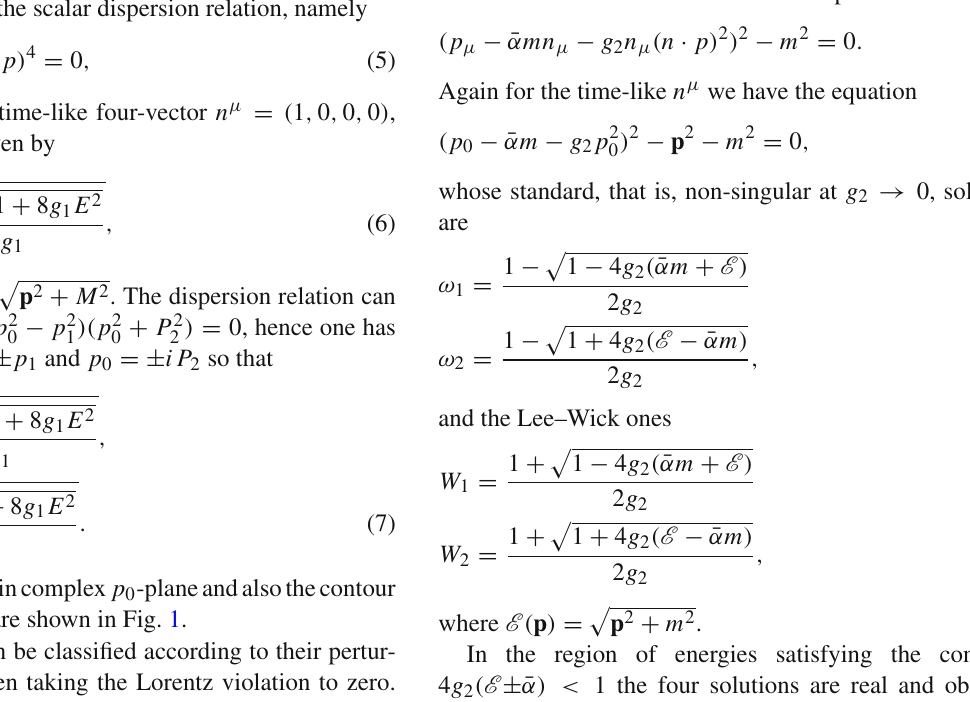
In the fermion sector we have the dispersion